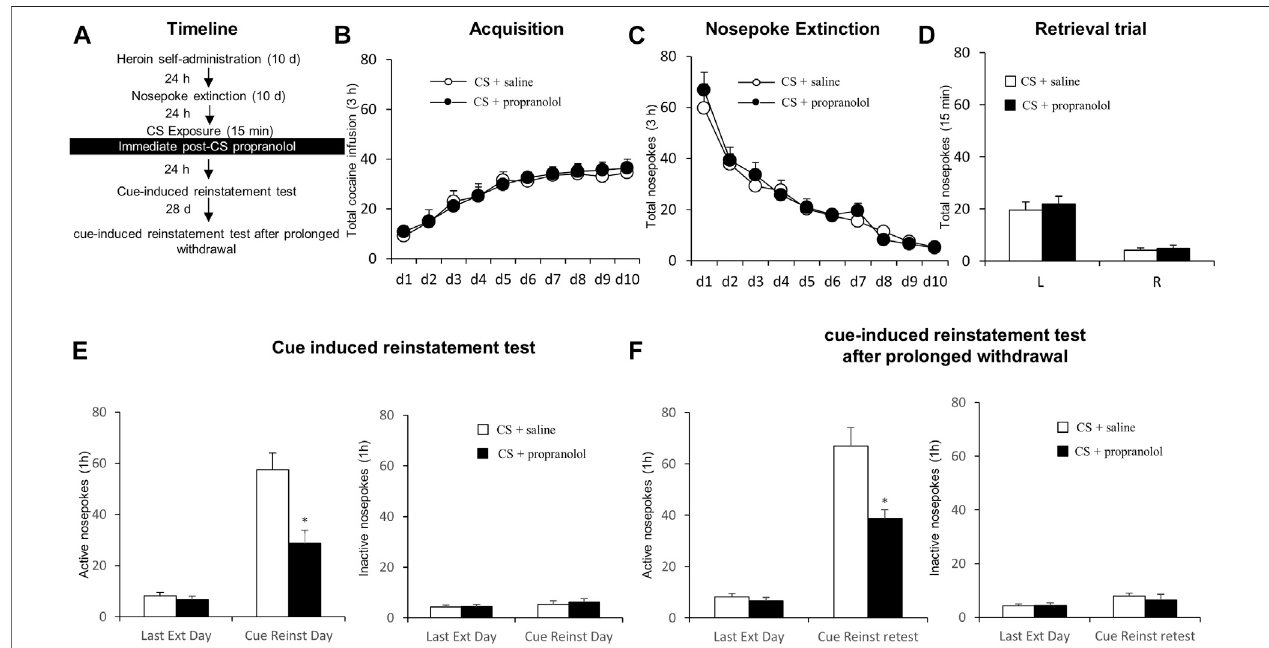
FIGURE2| PropranololtreatmentimmediatelyafterCSreactivationattenuatessubsequentandpost-abstinencecue-inducedreinstatementofheroinseeking. (A) Schematic representation of the experimental procedure. (B) Total number of infusions across heroin self-administration sessions. (C) Total number of active nosepoke responses across extinction sessions. (D) Nosepoke responses during a reactivation trial. (E) Active (left) and inactive (right) nosepokes during the last extinction session and cue-induced reinstatement test. (F) Active (left) and inactive (right) nosepokes during the last extinction session and cue-induced reinstatement test after prolonged withdrawal (after 28 days of